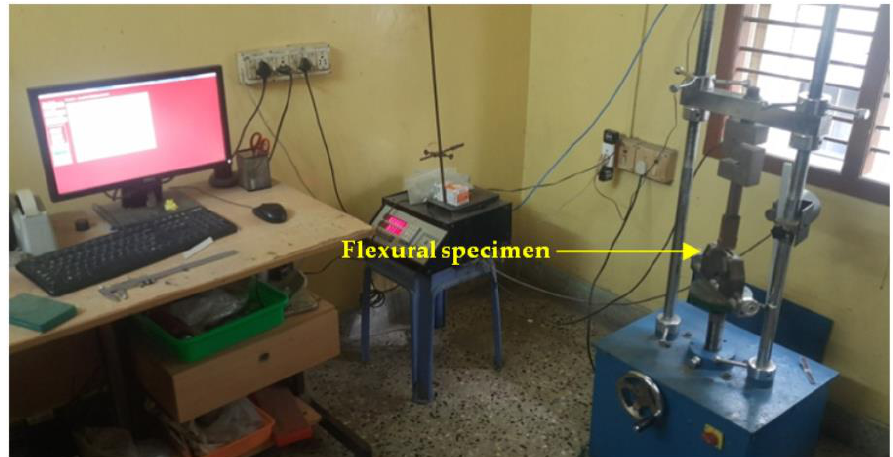
Figure 7. A universal testing machine was used to conduct the experiments.